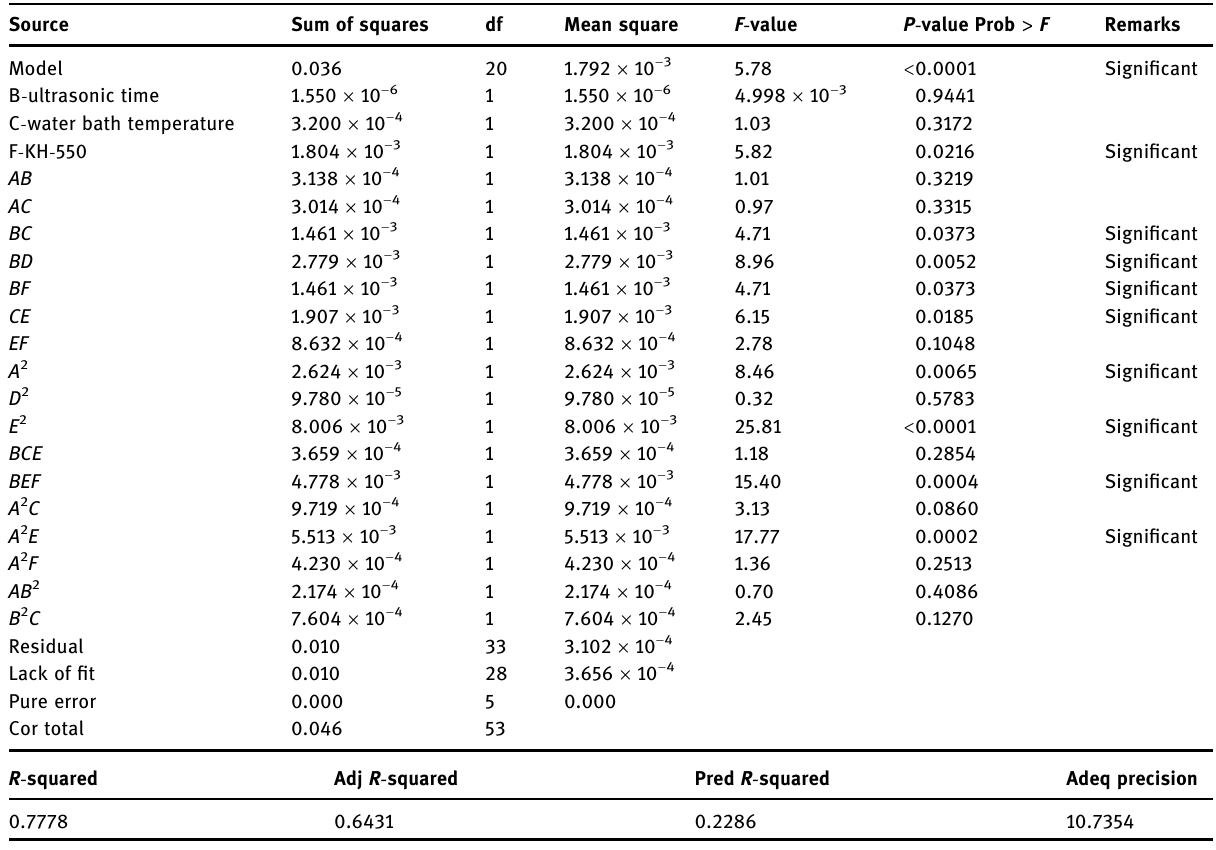
Table 3: Variance analysis of response surface experiments of heating